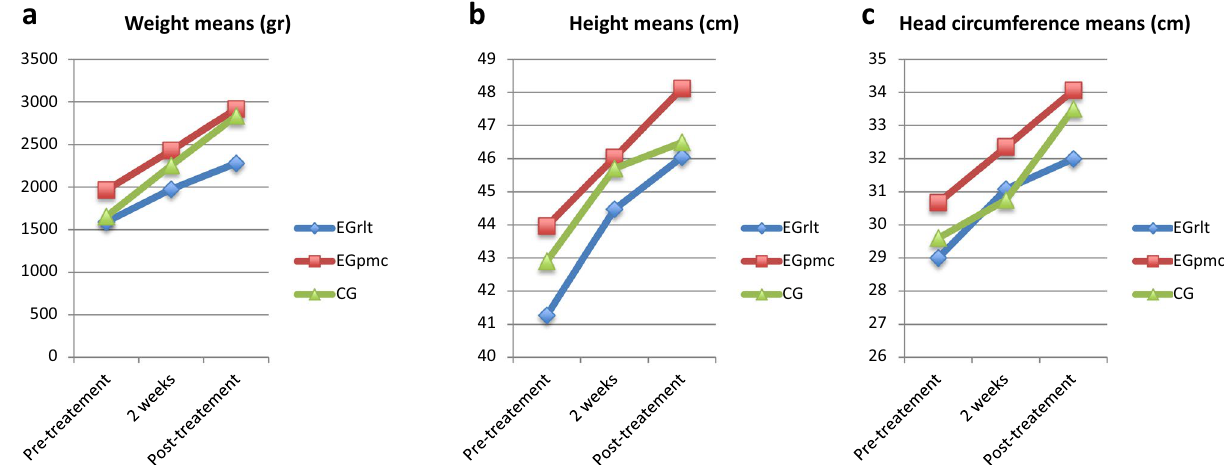
Figure 3. Effect of the intervention on the anthropometric measures of weight ( a ), height ( b ) and head circumference ( c